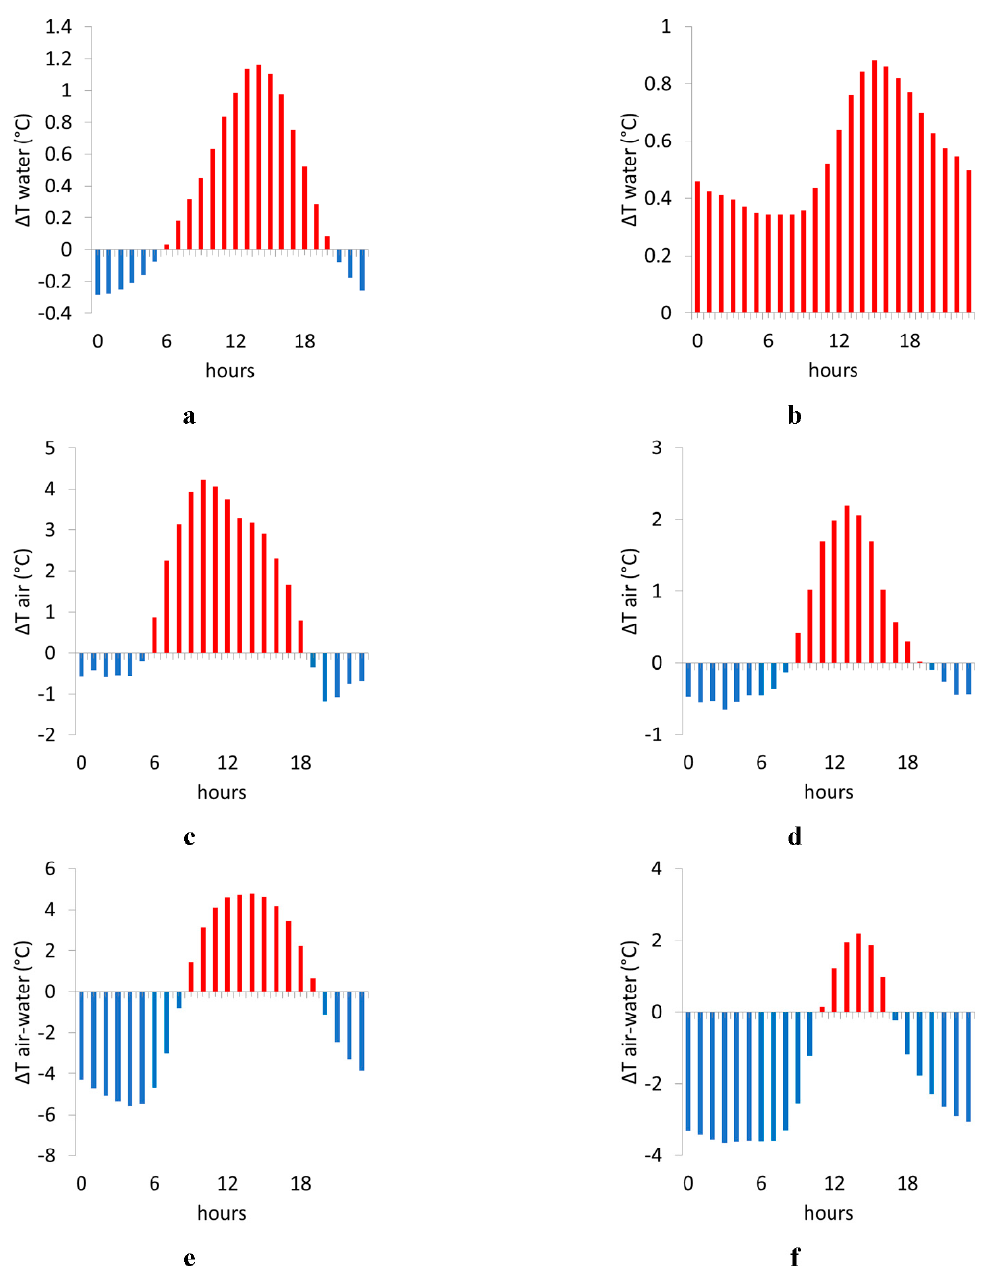
Figure 4. Hourly differences in the diurnal regime of temperature in 2019 during summer (left column) and winter (right column) for: Suceava River downstream—Suceava River upstream ( a , b ), floodplain air—Suceava Weather Station ( c , d ), floodplain air—Suceava River downstream ( e , f ).